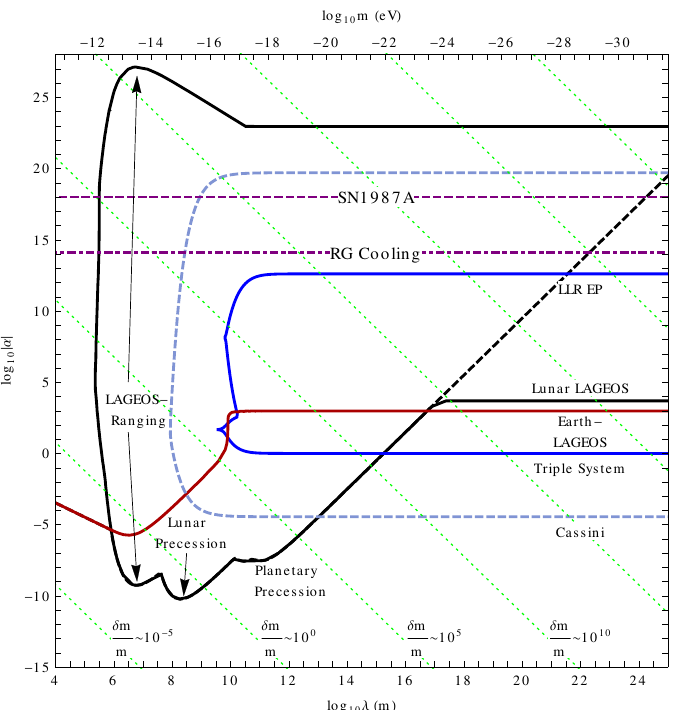
Figure 4 . Constraints on (cid:12)fth forces in the presence of natural quartic self-interactions from searches for EP-preserving forces excluding Earth-LAGEOS (black) and EP-violating forces (blue). The red contour indicates the constraint from Earth-LAGEOS [1], which is unbounded above as explained in the text, thereby closing all gaps in other experiments. Searches for EP-preserving forces shown include measurements made using the LAGEOS satellite [1, 33, 34], and the anomalous precession of the moon, Mercury and Mars [1, 35, 36]. The dashed black line shows the bounds in the absence of screening, while the solid contour shows the bounds with screening. The search for light de(cid:13)ection by the Cassini mission [17] is shown by a dashed light blue line. Searches for EP-violating forces shown include Lunar Laser Ranging (LLR-EP) [38] and the stellar triple system PSR J0337 (cid:0) 1715 [37]. These would not be present in the absence of screening. The purple dashed and dot-dashed lines indicate constraints from the cooling of SN1987A and Red Giants respectively [39{41]. The dotted green contours indicate the level of tuning of the mass required as a function of (cid:11)